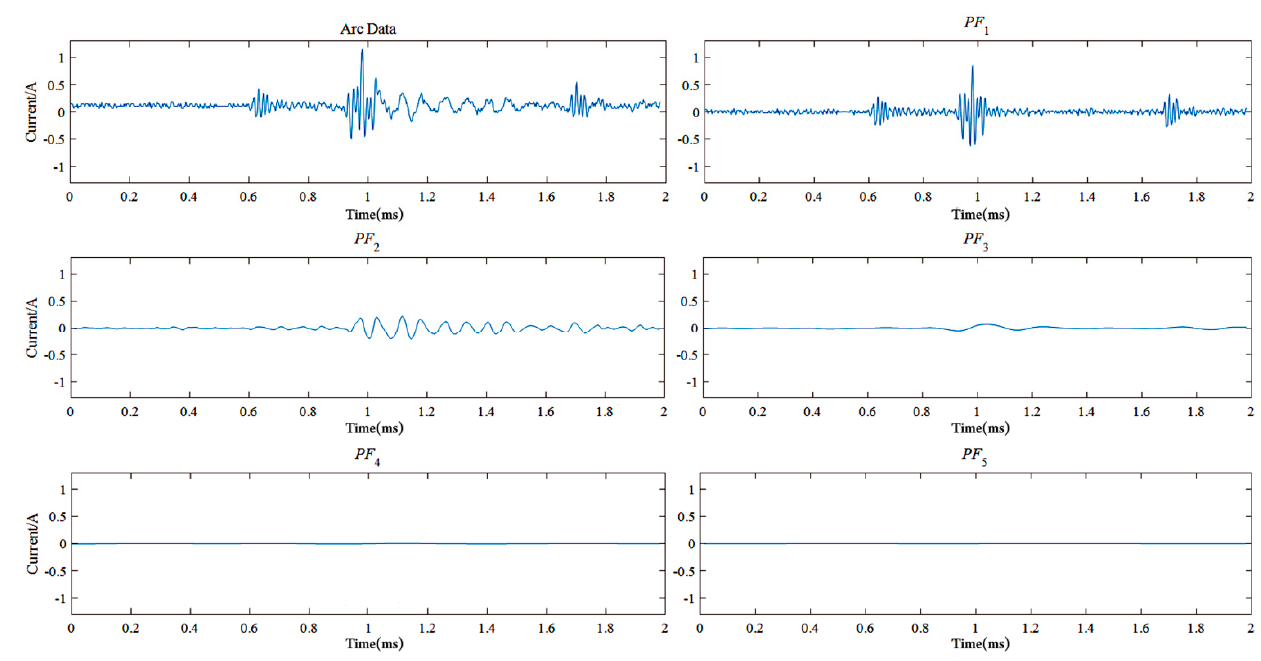
Figure 9. Waveforms of the arc and various PF s by ALMD.